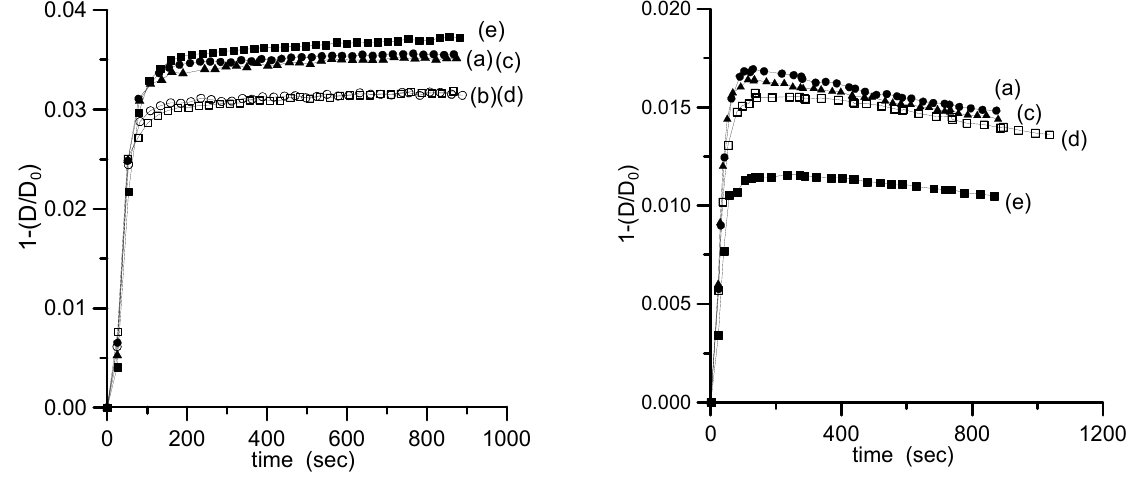
Figure 9. Representation of the polymerization shrinkage 1 − (D/D resin realized in the absence of PMMA and without additive ( a ), in the presence of 10 mg PMMA/0.5 g aerosil without additive ( b ), and in the presence of 10 mg PMMA/0.5 g aerosil with 1 g of the monomer ethyleneglycoldimethacrylate ( c ), polyethyleneglycoldimethacrylate of molecular weight equal to 330 ( d ) and 875 Da ( e ), respectively: successive polymerization runs of 20 s (left) and a single polymerization run of 20 s